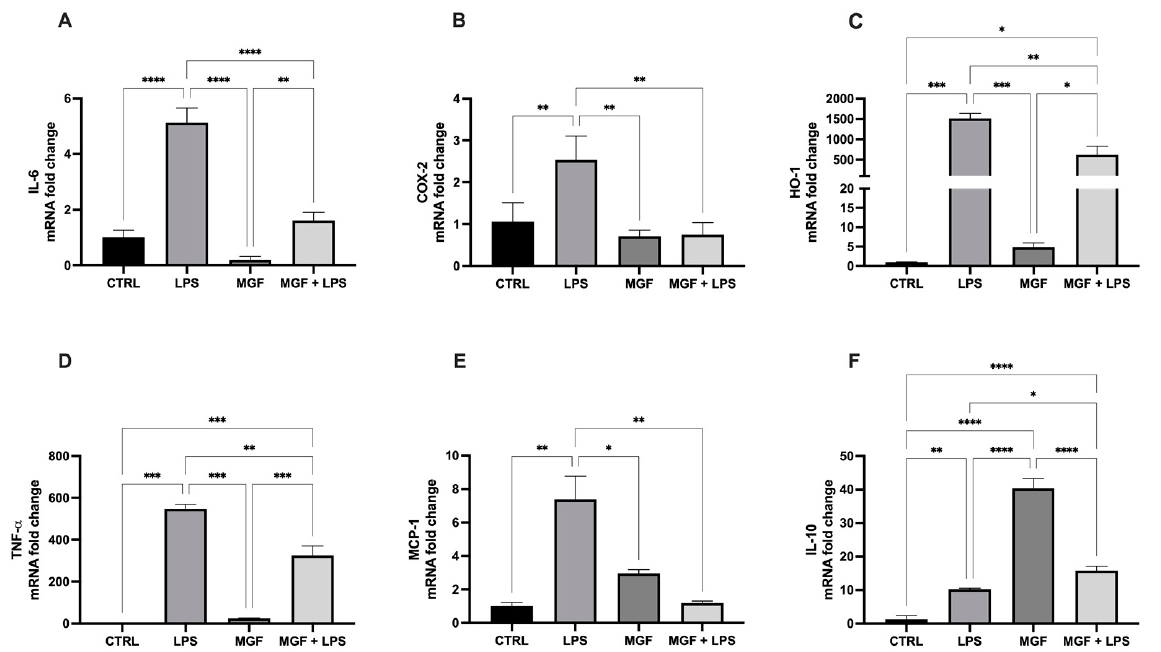
Figure 2. mRNA expression of IL-6 ( A ), COX-2 ( B ), HO-1 ( C ), TNF- α ( D ), MCP-1 ( E ) and IL-10 ( F ) in NCI-H292 cells. Cells were treated with LPS 10 µ g/mL for 1 h, and with MGF 20 µ g/mL for 24 h. * p < 0.05; ** p < 0.01; *** p < 0.001; **** p < 0.0001.